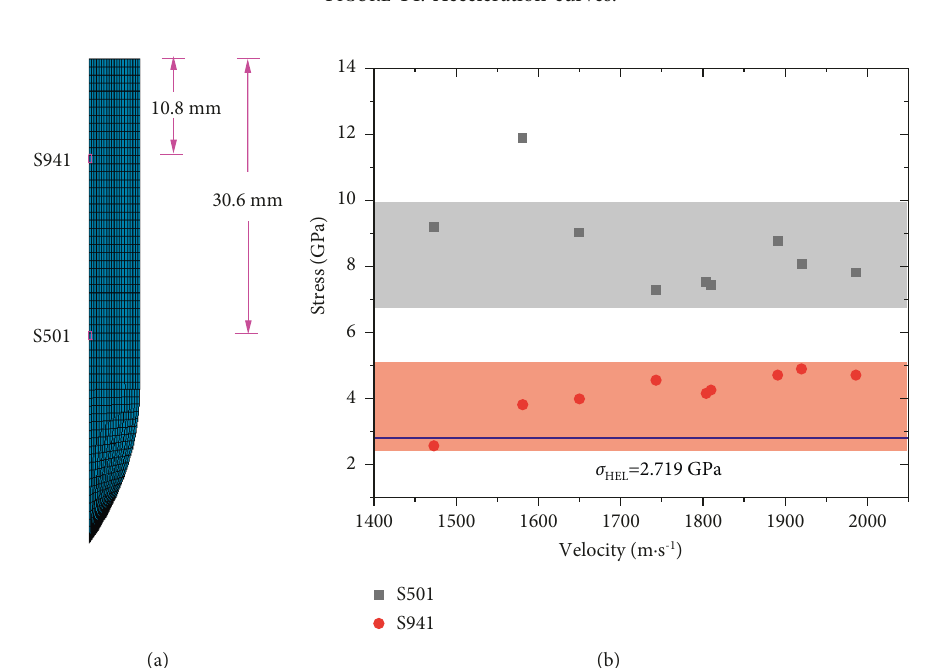
Figure 14: Acceleration curves.